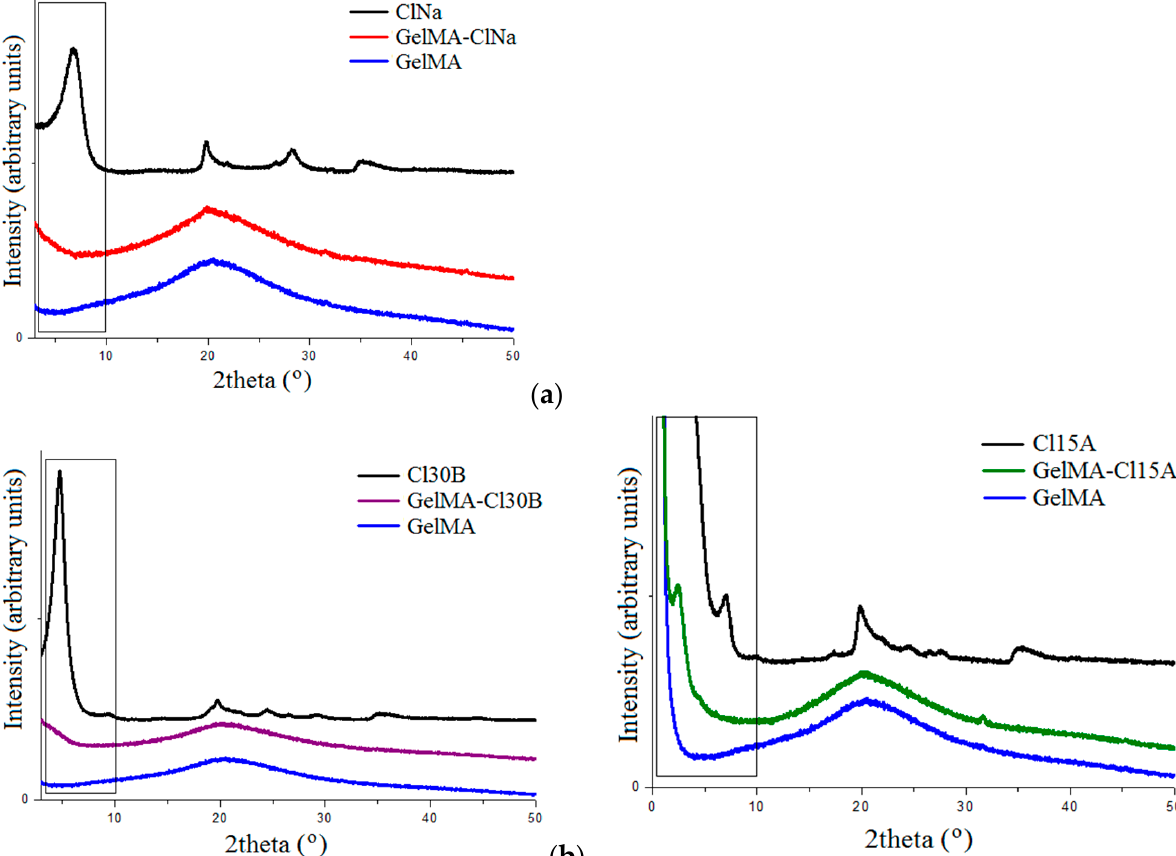
Figure 3. ( a ) X-ray diffractograms of commercial Cloisite Na, synthesized GelMA–Cloisite Na and GelMA matrix; ( b ) X-ray diffractograms of commercial Cloisite 30B, synthesized GelMA–Cloisite 30B and GelMA matrix; ( c ) X-ray diffractograms of commercial Cloisite 15A, synthesized GelMA–Cloisite 15A and GelMA matrix.